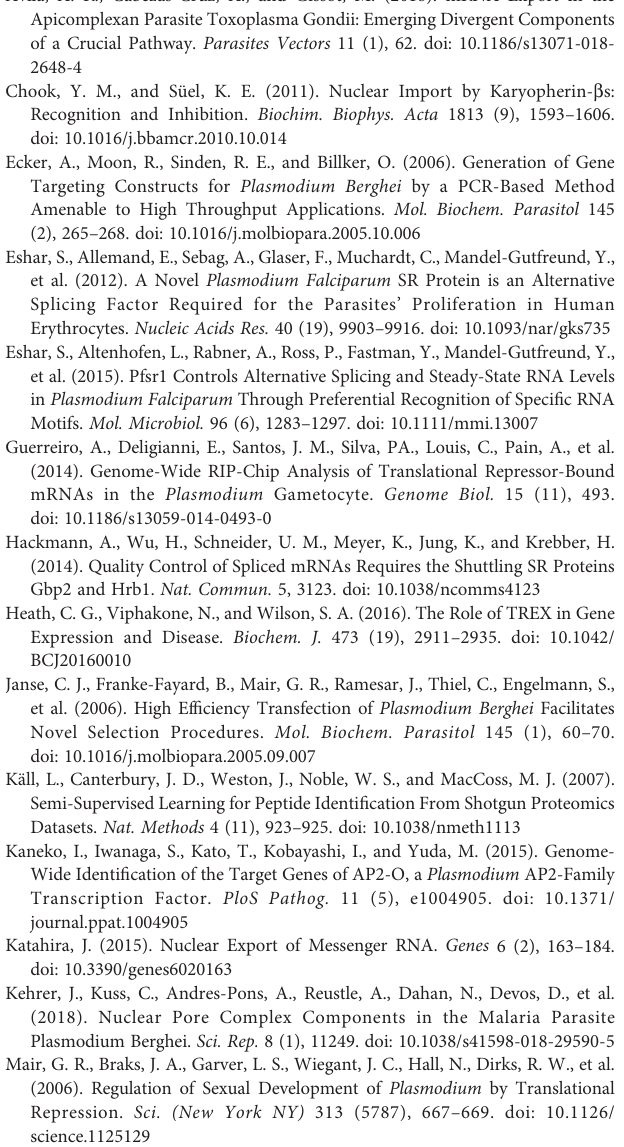
indicatesparasites transfected before LD. Correctintegration of mCherry and hdhfp into the 3 ′ regions of nab2 was con fi rmed by PCR (WT fragment, 1744 bp; NAB2:: mCherry fragment, 4544 bp). (C) Introduction of the nup205::gfp cassette into the 3 ′ region of the nup205 locus of NAB2::mCherry P. berghei ANKA. The correct integration of gfp and hdhps into the 3 ′ region of nup205 was con fi rmed by PCR (WT fragment, 1624 bp; NUP205::GFP fragment, 6153 bp). Supplementary Figure S3 | Schematic representation of mRNA export by GBP2 and NAB2 in malaria parasites. (A) GBP2 and NAB2 typically bound to different mRNAs in malaria parasites. (B) No nuclear pore complex proteins or export receptor-like proteins were identi fi ed in this study. (C) The GBP2-binding mRNAs may also be exported via the CRM1/exportin pathway. (D) GBP2 interacts with ALBA4, DOZI and CITH. (E) Transportin is involved in the nuclear import of